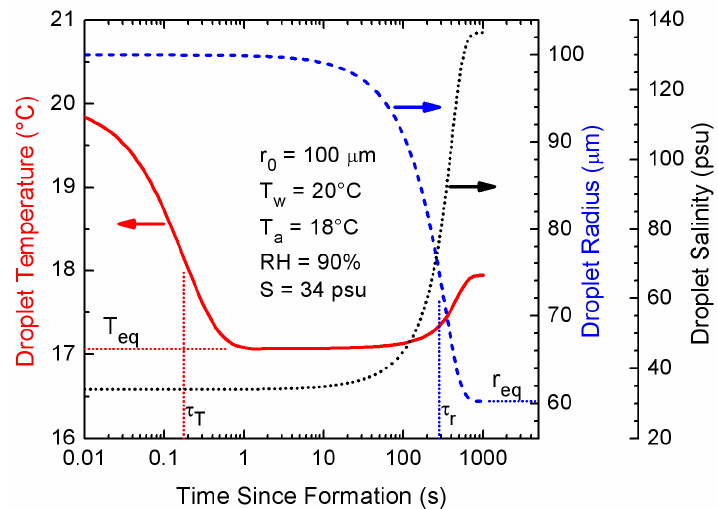
Figure 1. Results of a microphysical model [39] that predicts the temperature, radius, and salinity evolution of an individual spray droplet. This particular droplet formed with an initial radius of 100 µ m ( r 0 ) from surface seawater of 20 ◦ C ( T w ) and salinity 34 psu ( S ). It was thrown into air of temperature 18 ◦ C ( T a ) and relative humidity 90% ( RH ). The barometric pressure was 1000 mb. The T eq , r eq , τ T , and τ r are, respectively, the equilibrium temperature and radius and the e-folding times for the temperature and radius evolution.